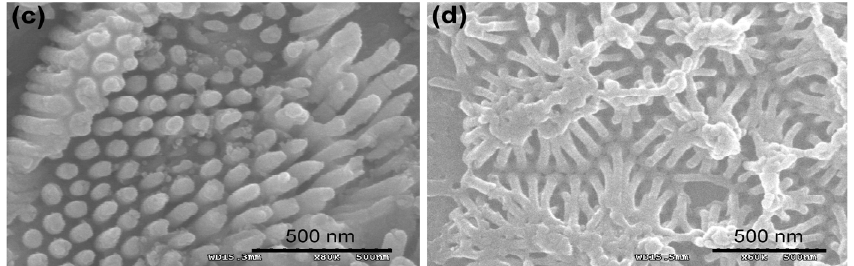
Figure 2. Representative scanning electron microscopy (SEM) images of the Au surfaces employed in the cell experiments. The images obtained at 20 Hz from the sample pre-coated with Pt-Pd alloy. ( a ) Freshly cleaned bare Au surface prior to peptide immobilization; ( b ) 2D-RGD nanodots; ( c ) 3D-RGD nanorods; and ( d ) 3D-RGD nanopillars array. Scale bar 500 nm. Reproduced with permission from [35], Copyright 2012, Elsevier.